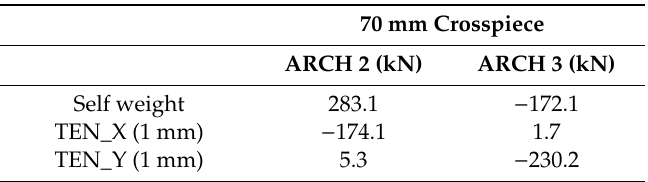
Table 16. The influence matrix loads on arches 2 and 3 with 70 mm crosspiece, a rigidity of 171 kN / mm and a weight limit of 675